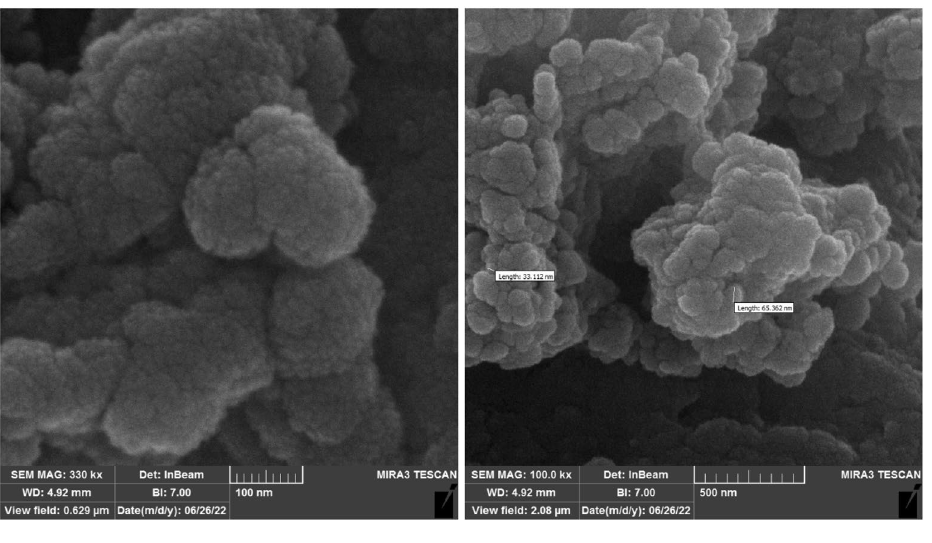
Figure 2. SEM images of Sm-bis(PYT)@boehmite.